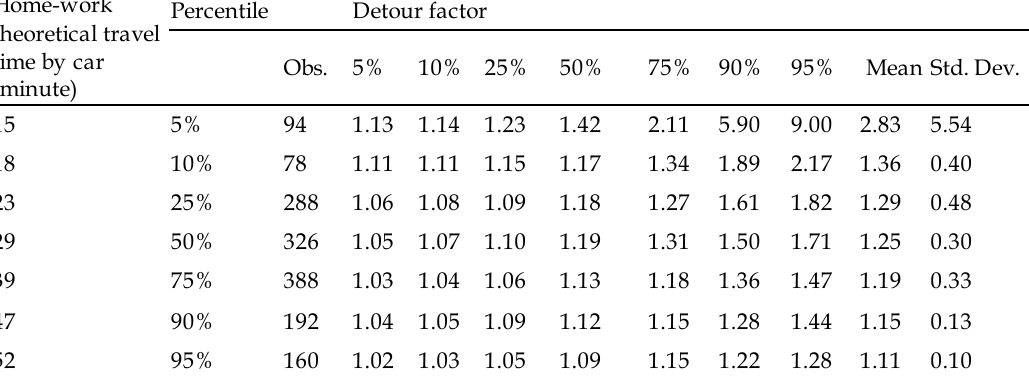
Table 3. Empirical results of detour factor Home-work